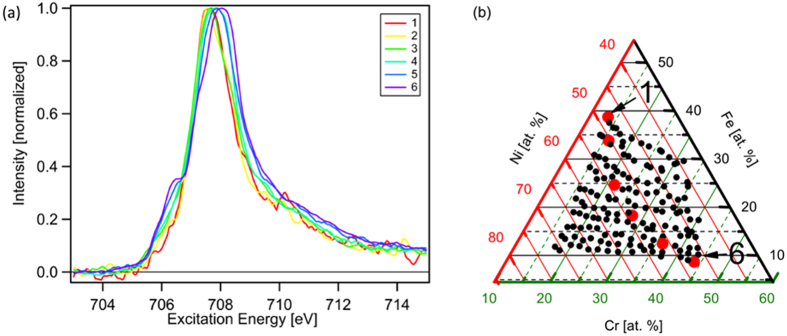
(a) Fe L3-edge of Ni1-y-zFeyCrzOx of the compositions 1–6 denoted in the ternary diagram in (b).